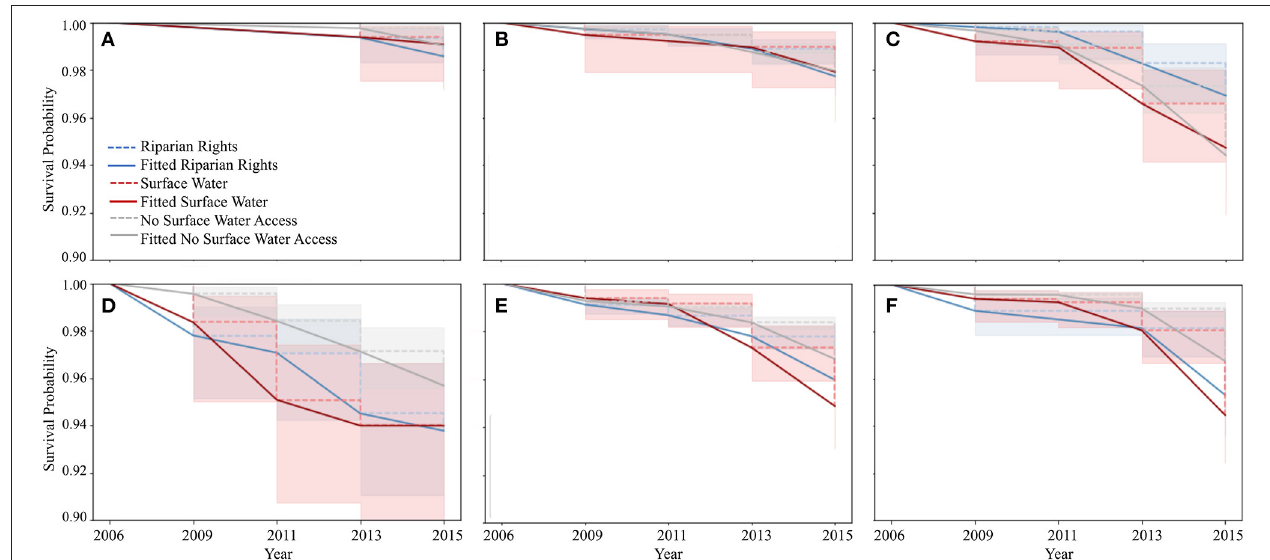
FIGURE 2 | Survival probability curves for each water group (i.e., surface water access) for the (A) Mountains, (B) Northern Valley, (C) Black Belt, (D) Plains Piedmont, (E) Wiregrass, and (F) Coastal regions of